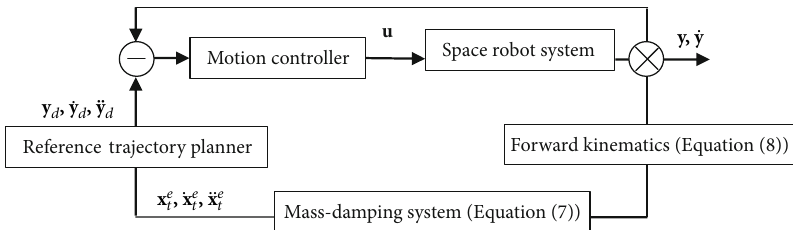
Figure 9: Control system block diagram.